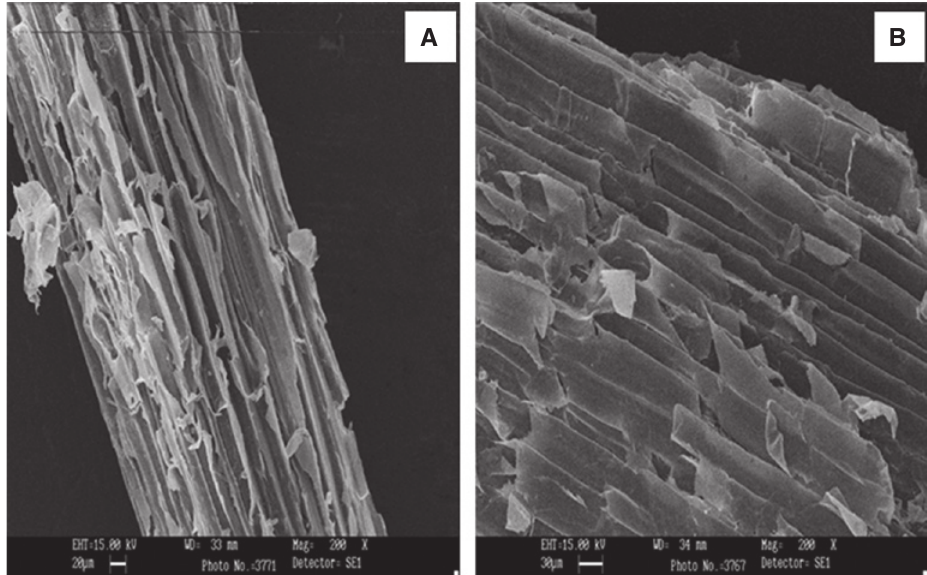
Figure 13: SEM micrograph of (A) untreated BF and (B) treated